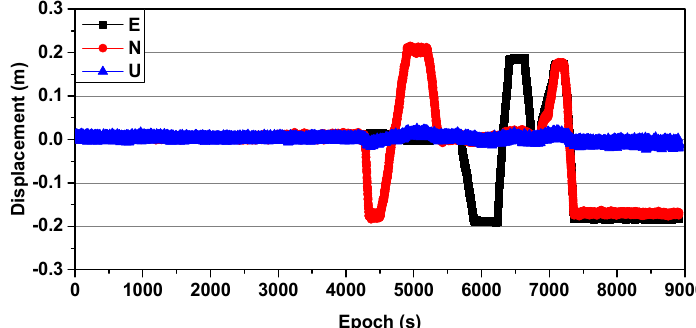
Figure 5. Displacement sequence obtained with CD01 as the reference station and CD02 as the monitoring station.